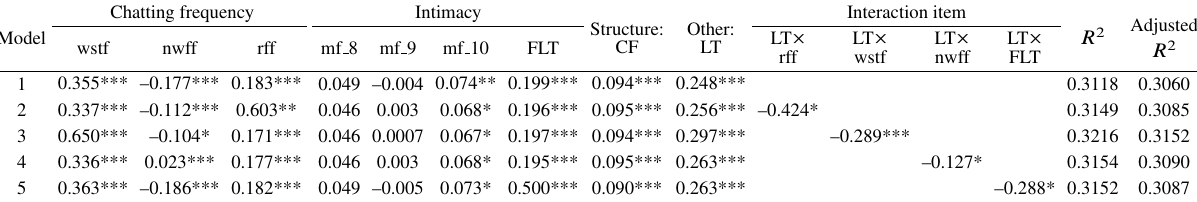
Table 3 Interaction multivariate linear